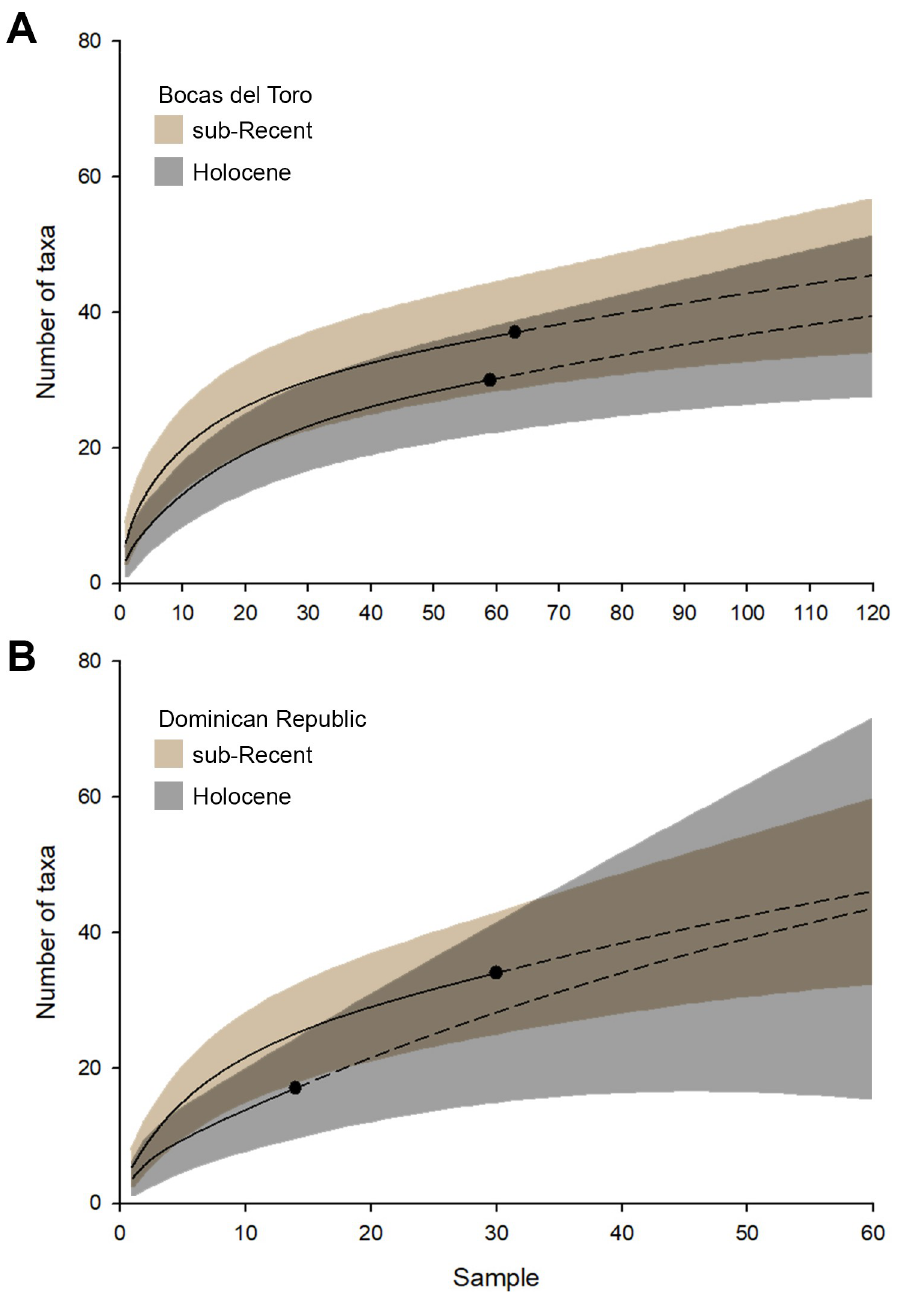
Fig 10. Sample-based rarefaction and extrapolation curves with 95% confidence intervals. Reference samples are indicated by solid circles, rarefaction by solid lines, and extrapolation by dashed lines.